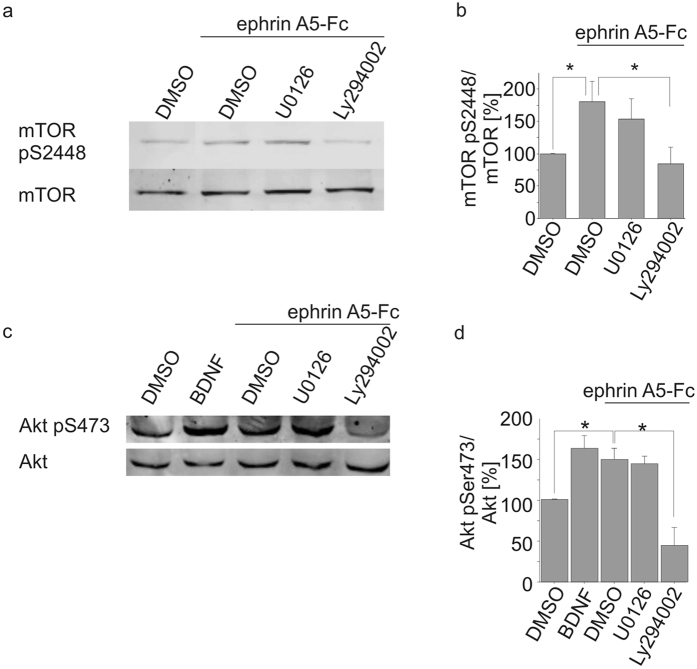
Ephrin A5-Fc stimulation induces mTOR phosphorylation.Protein lysates of cortical neurons treated with BDNF or ephrin A5-Fc as well as inhibitors for PI3K (Ly294002) or MEK (U0126) were submitted to SDS-PAGE and Western blotting. mTOR (a,b), ERK1/2 and Akt1 (c,d,e). Protein expression was determined by densitometric analysis of the corresponding protein bands. Phosphorylation was quantified and calculated as ratios of signals obtained with antibodies specific for pan-mTOR and phospho-mTOR (mTOR pS2448) or pan-Akt1 and phosphor-Akt1 (pS473). For mTOR: n = 5; for Akt1 n = 3. ANOVA, Fisher-PLSD; *p < 0.05 **p < 0.01; error bars: S.E.M.